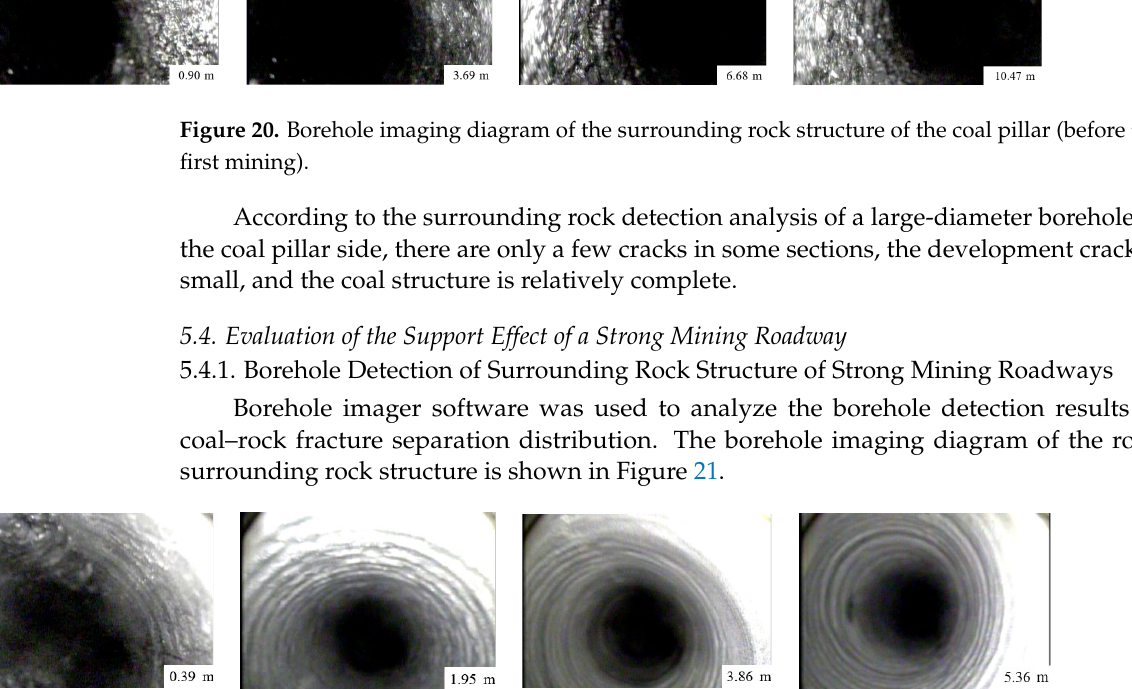
Figure 21. Borehole imaging diagram of the roof ‐ surrounding rock structure.